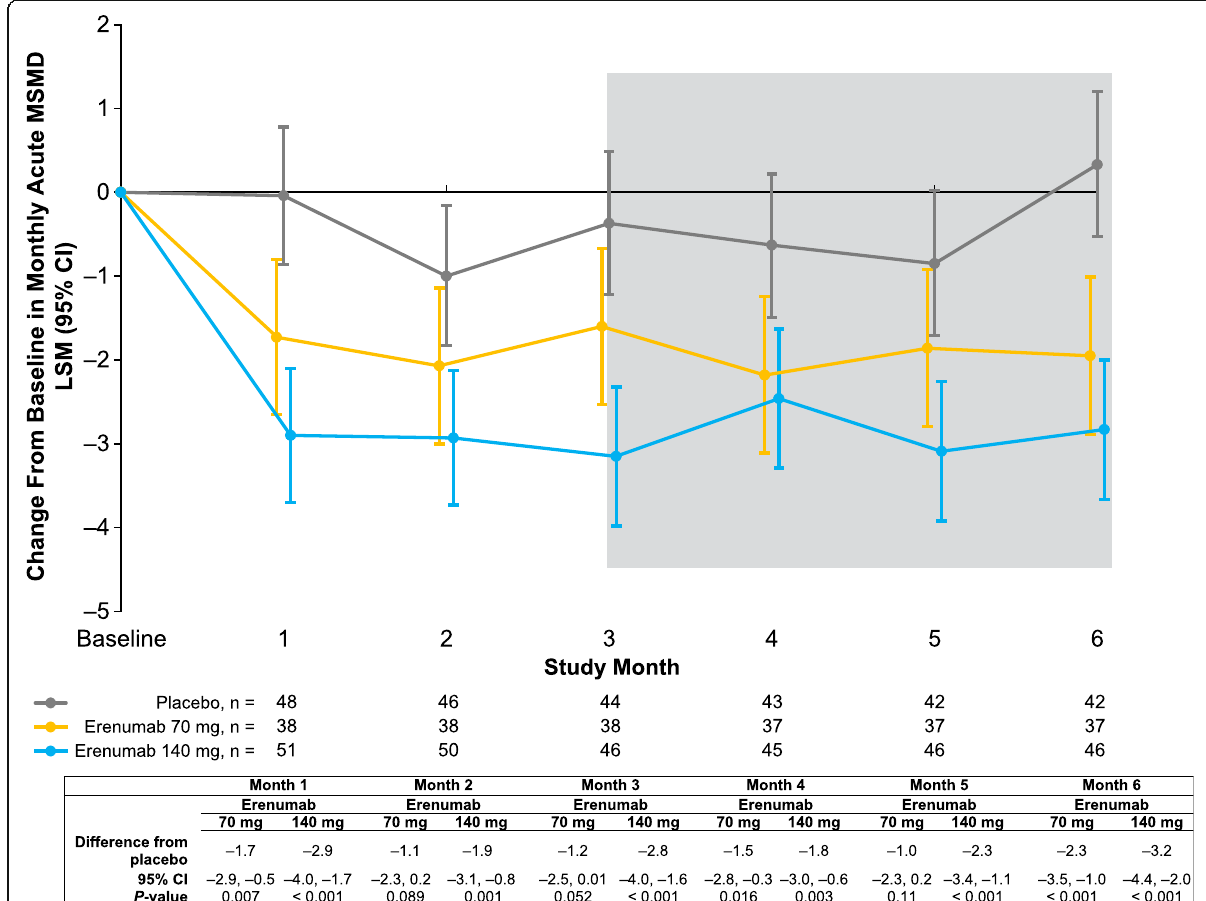
Fig. 2 Change from baseline in monthly acute MSMD among patients with a self-reported history of menstrual migraine who took migraine- specific medications at baseline. Data are shown as LSM with 95% CIs. The gray shaded area represents months 4 – 6. Abbreviations: CI, confidence interval; LSM, least squares mean; MSMD, migraine-specific medication